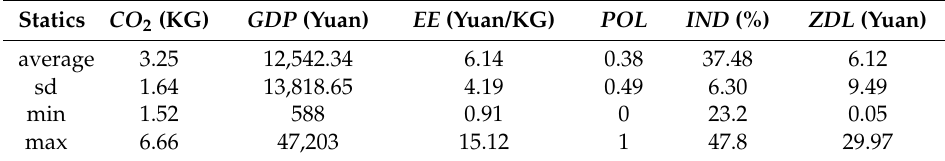
Table 2. Key statistics of the